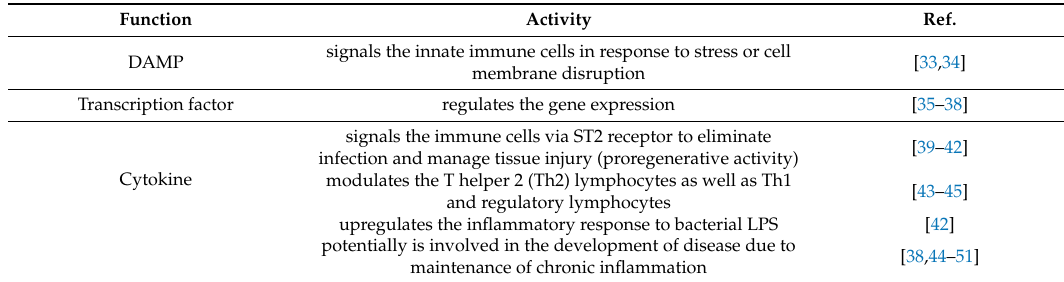
Table 1. Summary of major IL-33